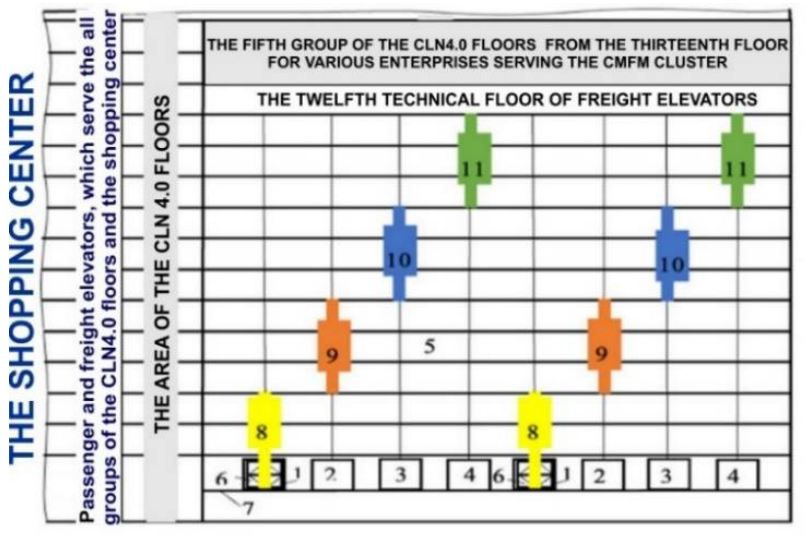
Figure 3. Multi-floor CLN4.0 (front view): 1, 2, 3, 4—freight elevators; 5—multi-floor CLN4.0 building; 6—CCs (multi-IRTs); 7—overpass; 8—the first group of CLNs4.0 floors (highlighted in yellow) from the ground floor to the second floor, which are served by the distributed pair(s) of freight elevators 1; 9—the second group of CLN4.0 floors (highlighted in orange) from the third floor to the fifth, which are served by the distributed pair(s) of freight elevators 2; 10—the third group of CLN4.0 floors (highlighted in blue) from the sixth floor to the eighth, which are served by the distributed pair(s) of freight elevators 3; 11—the fourth group of CLN4.0 floors (highlighted in green) from the ninth floor to the eleventh, which are served by the distributed pair(s) of freight elevators 4.